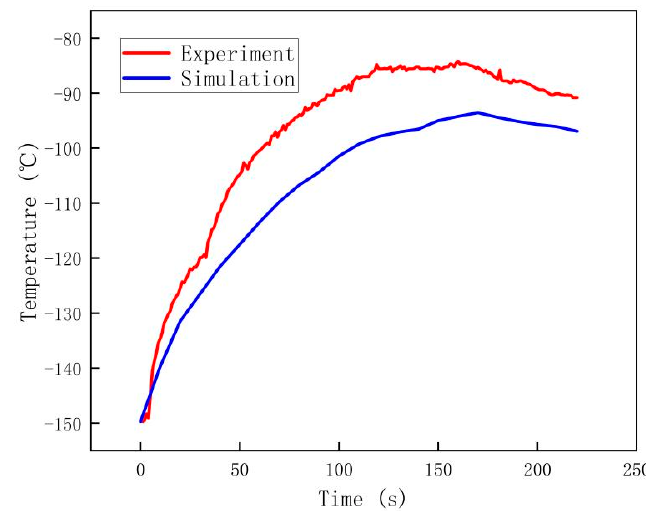
Figure 9. Drill bit temperature curve for No. A1 in experiment and simulation.